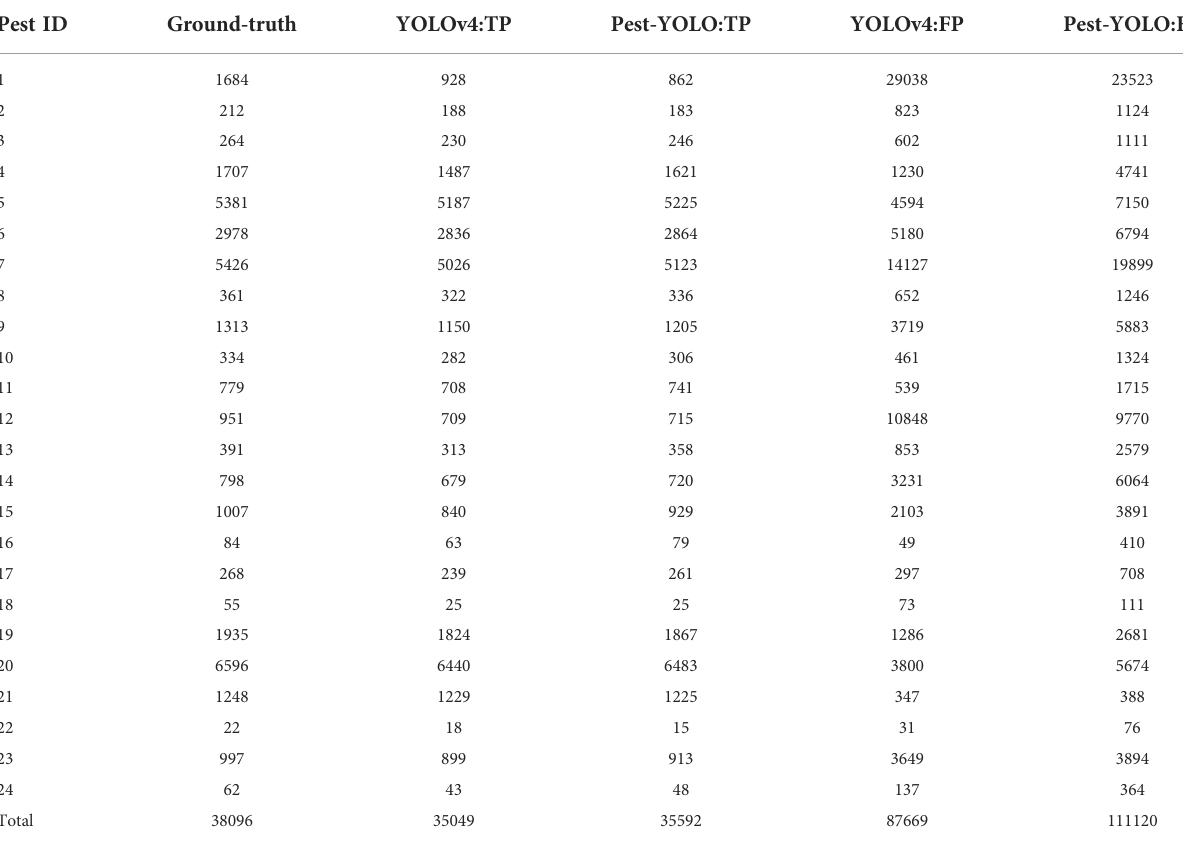
TABLE 4 Number of annotations per pest category in the dataset and the numbers of TPs and FPs detected by the YOLOv4 and Pest-YOLO models. Pest ID